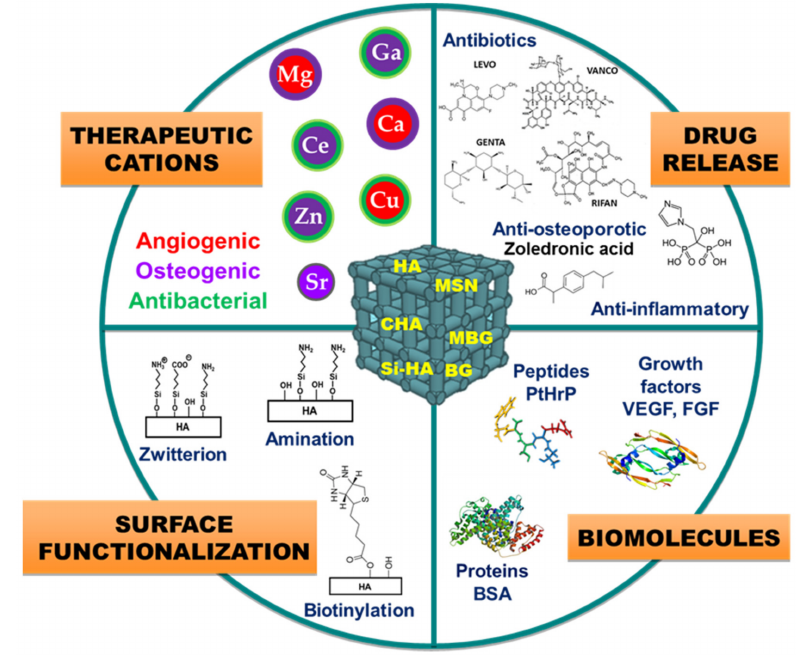
Figure 3. Representation of bioceramic scaffold modifications for bone